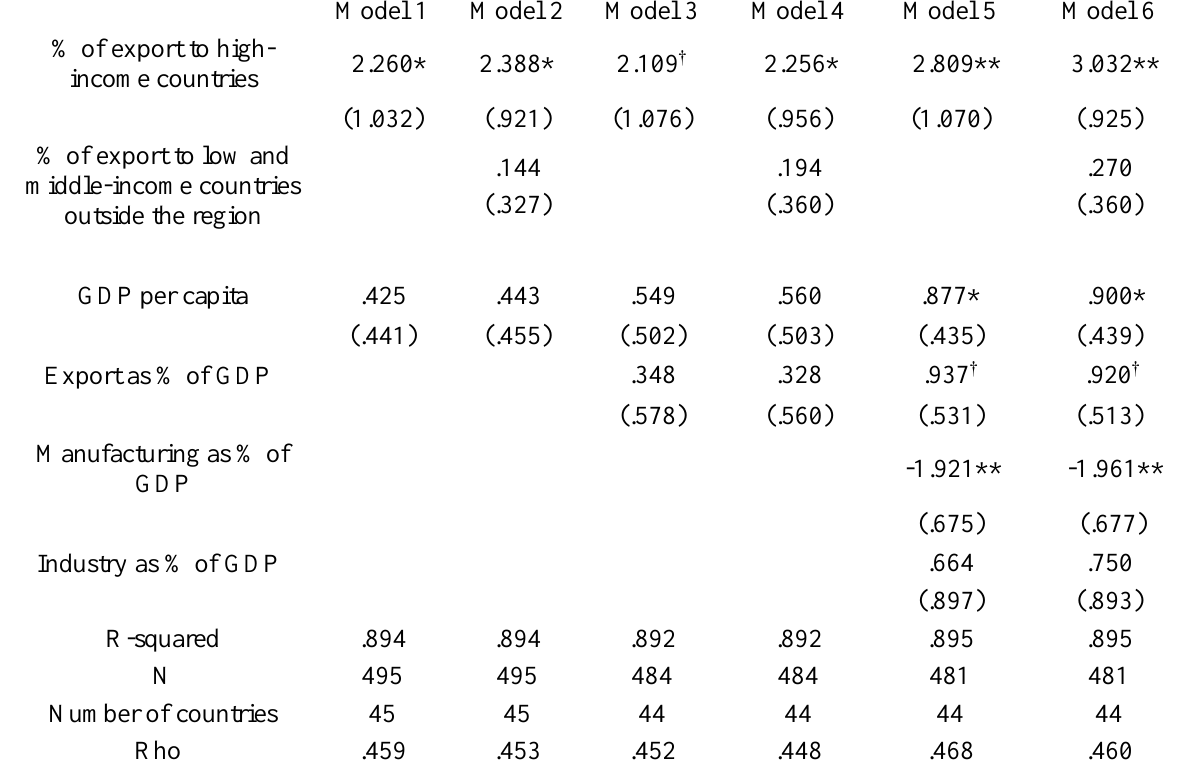
Table 7. Regression of Plastic Waste Export Trade Value, 2003-2013, Two-Way Fixed Effects PW Model Estimates for 45 High-Income